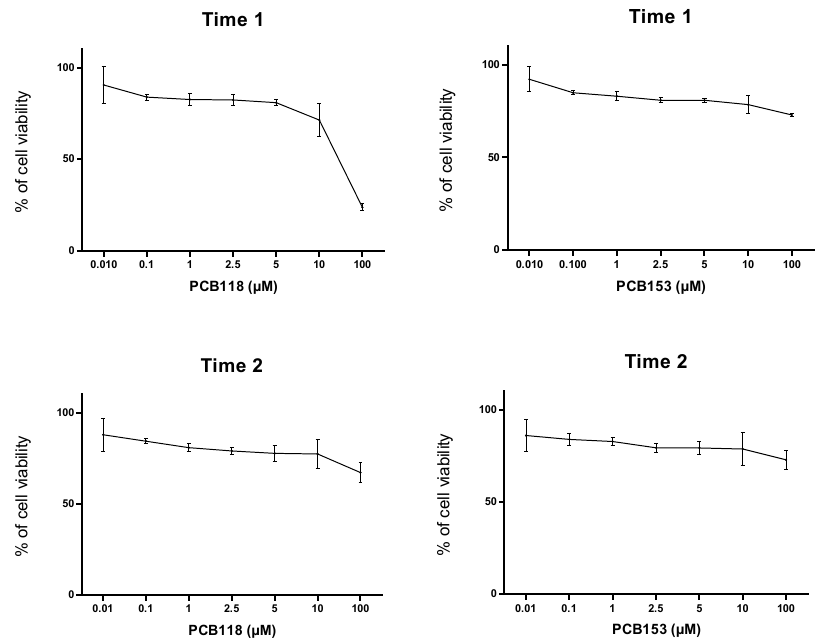
Figure 2. Results of MTT assays performed in “Time 1” and “Time 2” conditions after PCB118 or PCB153 exposure. 3T3-L1 cells were incubated with or without PCB118 (one or five micromolars) or PCB153 (one or five micromolars) according to the “Time 1” or “Time 2” conditions, and MTT assays were performed as described in materials and methods section.